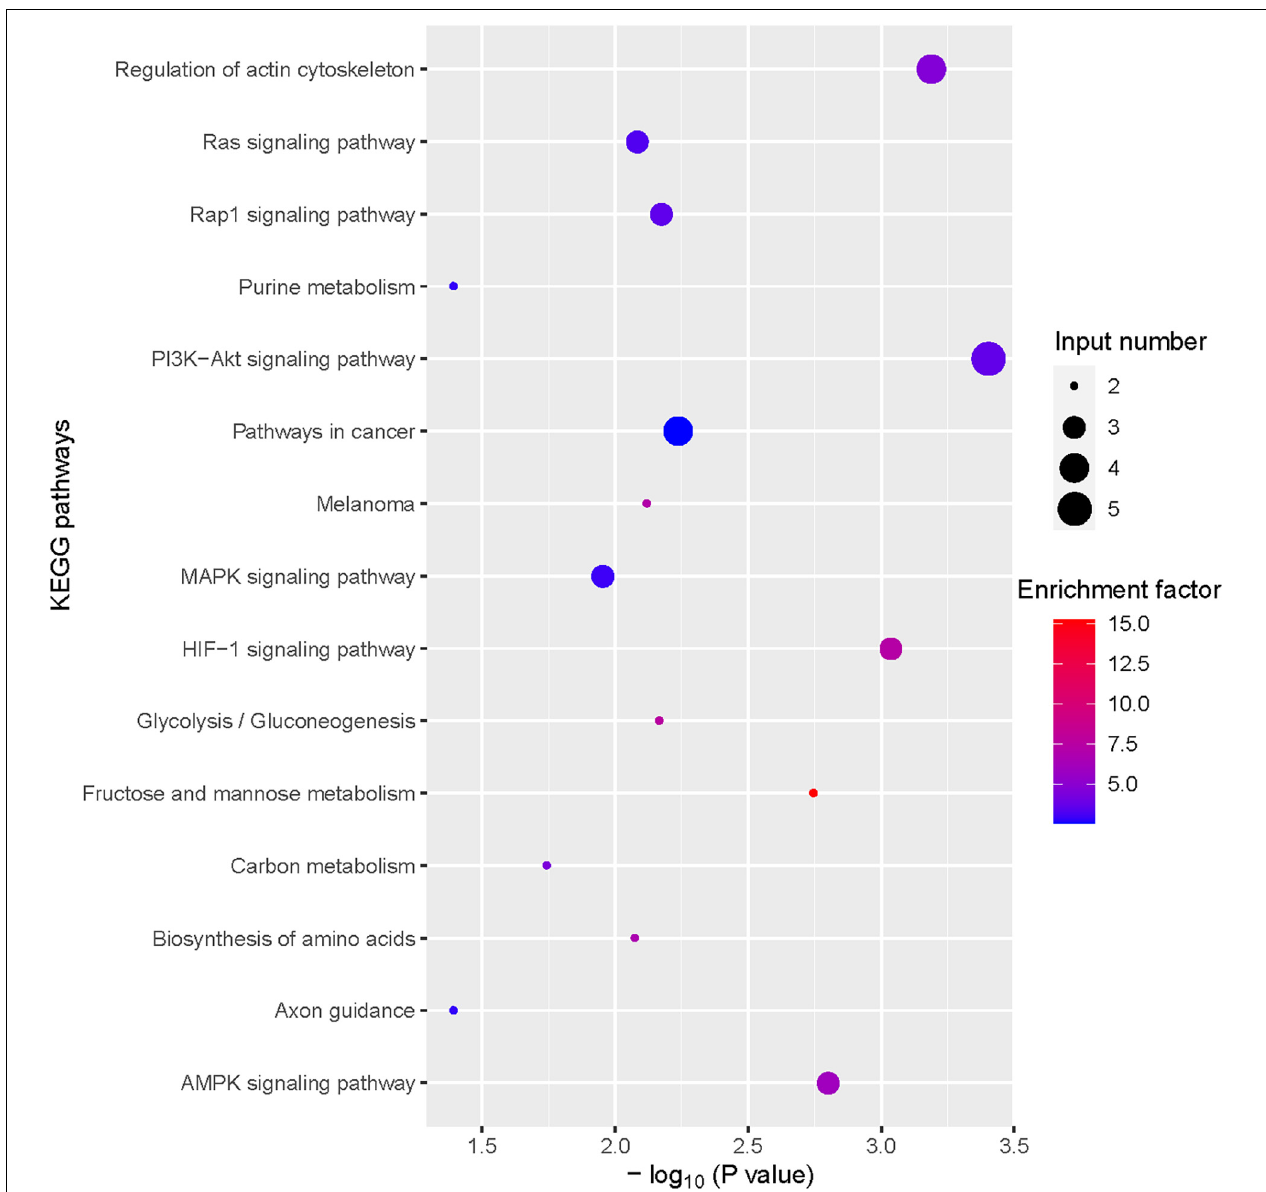
FIGURE 4 | Bubble plot of Kyoto Encyclopedia of Genes and Genomes (KEGG) enrichment of differentially expressed gene (DEGs) (TOP